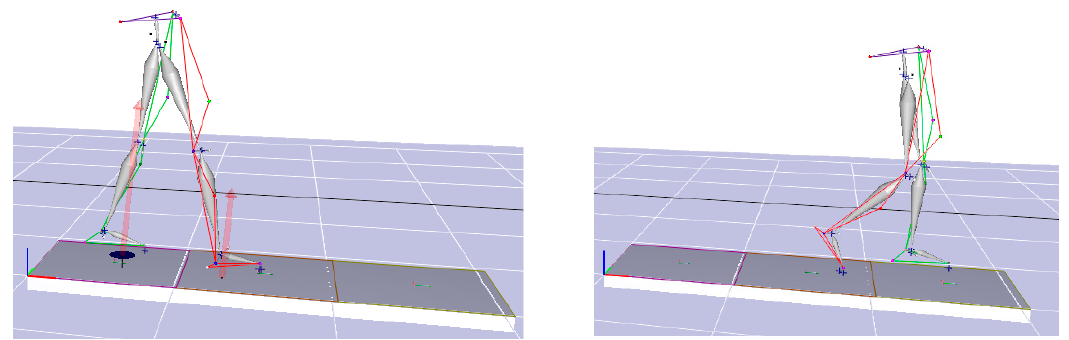
Figure 5. Cortex software environment during motion analysis test.